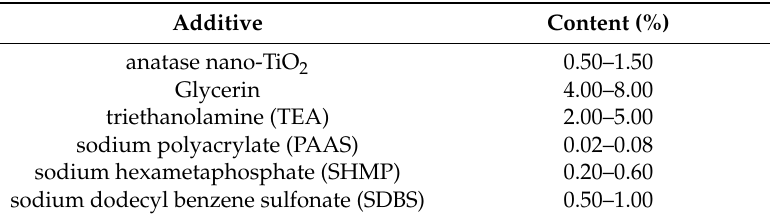
Table 1. Main additives of the nano-TiO 2 lubricating